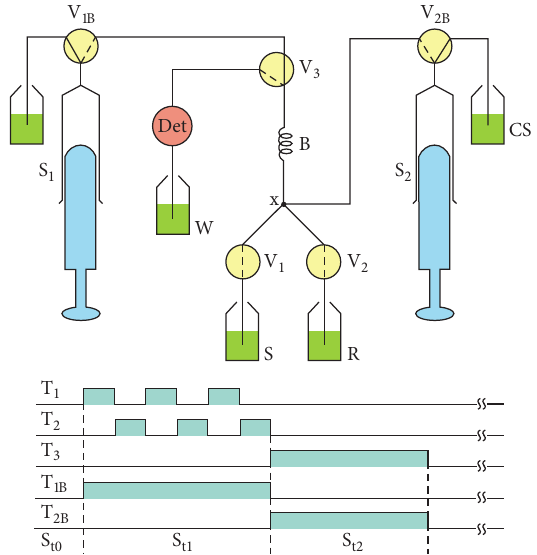
Figure 1: Diagram of the flow system manifold. S 1 and S 2 = syringes; V 1 , V 2 , and V 3 = three-way solenoid valve; V 1 and V 2 = two-way B B solenoid; pumping flow rate at 50 𝜇 Ls −1 ; A = sample; R = reagent (SnCl 2 and KSCN); Cs = carrier solution (hydrochloric acid 1.5 molL −1 ); B = reaction coil, 100cm long and 0.8 mm inner diameter; Det = photometer, 𝜆 = 470 nm; W = waste; T 1 , T 2 , T 3 , T 1 , and T 2 = switching time B B diagram for valves V 1 , V 2 , V 3 , V 1 , and V 2 , respectively. Dashed and solid lines in the valve symbols indicate the fluid pathway when the B B valves were switched on or off, respectively. Dashed lines in the symbols of valves V 1 and V 2 indicate that they are normally closed, therefore